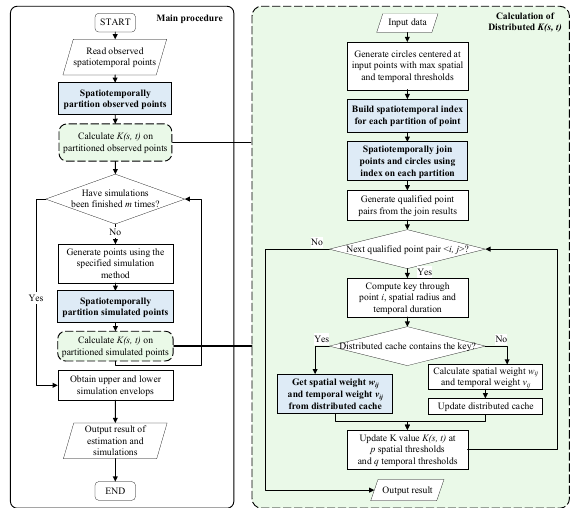
Figure 2. Optimized distributed calculation workflow by taking space-time K function as an